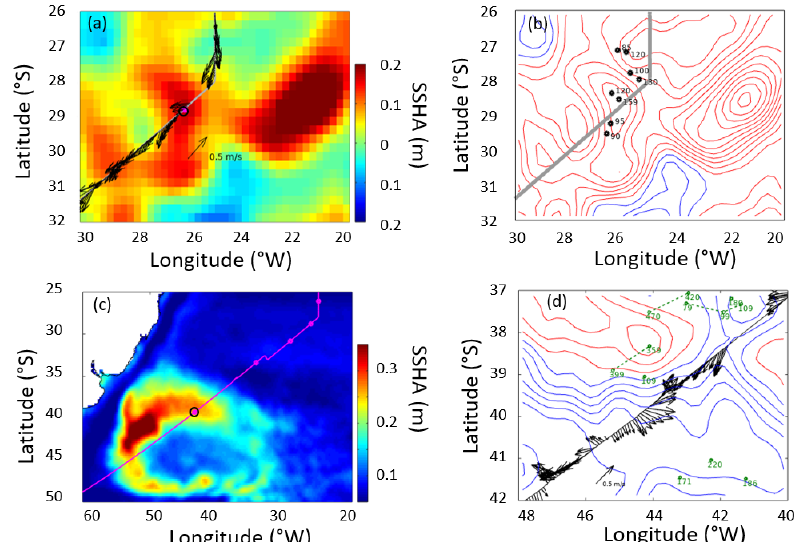
Figure 10. Altimetry, ship, and Argo profiler data relating to the two anomalous stations, indicated by magenta dots with black boundaries. (a) Sea surface height anomaly (SSHA) at the time of the 28 ◦ S station. The altimetry shows a high (anticyclone) centred on the station, with a larger feature further east. The arrows provide the currents at 54m depth from the shipborne ADCP. (b) The same altimetry data as contours (intervals of 0.03m), with dots indicating Argo profiles within 5d of ship passage and the numbers being the mixed-layer depth (depth at which temperature drops by more than 3 ◦ C below the surface value). (c) The root mean square variability in SSHA showing the pattern of large signals associated with the Brazil–Falklands Confluence, and the position of the 39 ◦ S station. (d) Contours of SSH (0.10m increment, with red for the zero and positive values, blue for the negative values). The arrows show currents from the shipborne ADCP at 54m depth, and the dots and green numbers indicate Argo profiles and the depth of the surface layer within 10d of ship transit. (Green dashed lines link successive profiles of the same float, with all three being advected